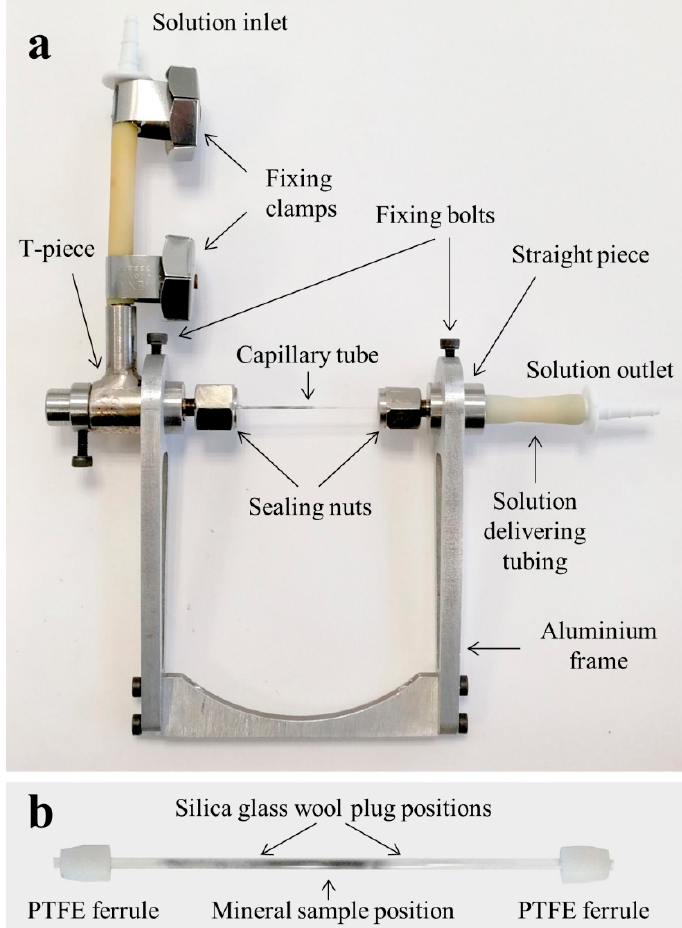
Figure 3. Photos of ( a ) the sample cell, and ( b ) capillary tube.